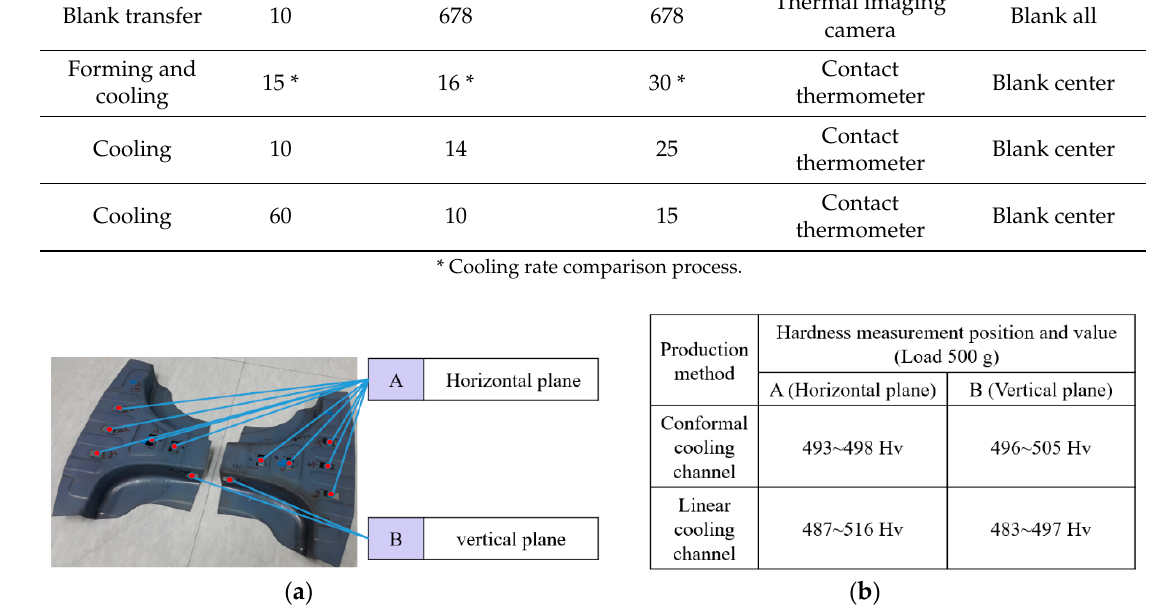
Figure 20. Vickers hardness measurements of the hot stamped product: ( a ) measurement positions (horizontal and vertical plane), ( b ) Vickers hardness measurements.